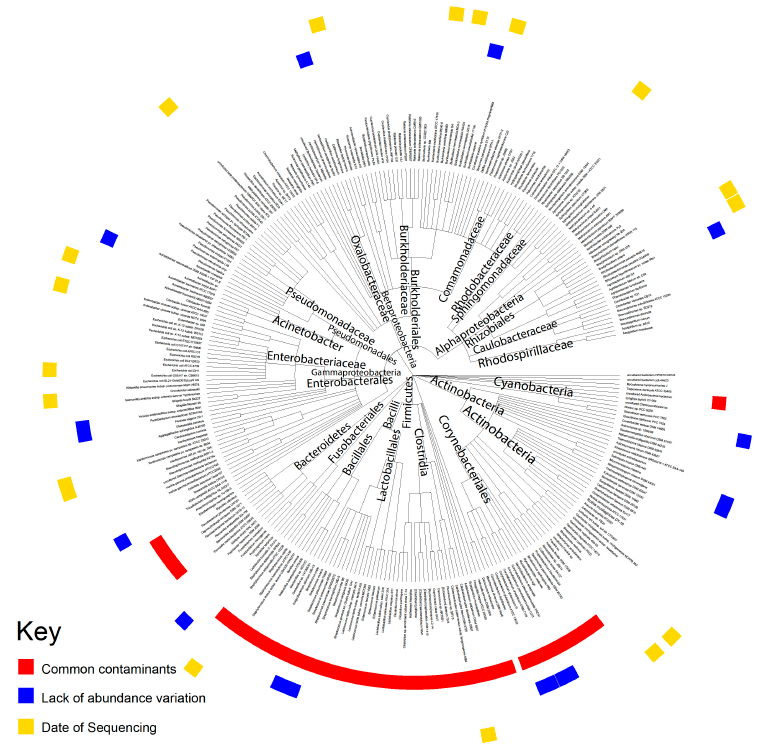
Figure 1. Contamination correction of TCGA data. A summary of the three contamination correction methods used: filtering for common contaminants, microbes with little variation in abundance across patients, and microbes with unusually high abundance corresponding to specific